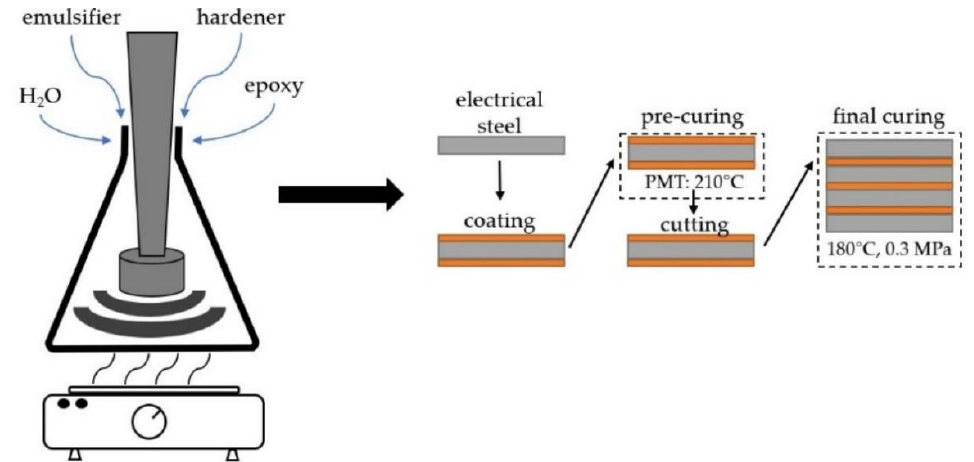
Figure 2. Schematic illustration of varnish preparation ( left ) and electrical steel coating, stacking and lamination ( right ).